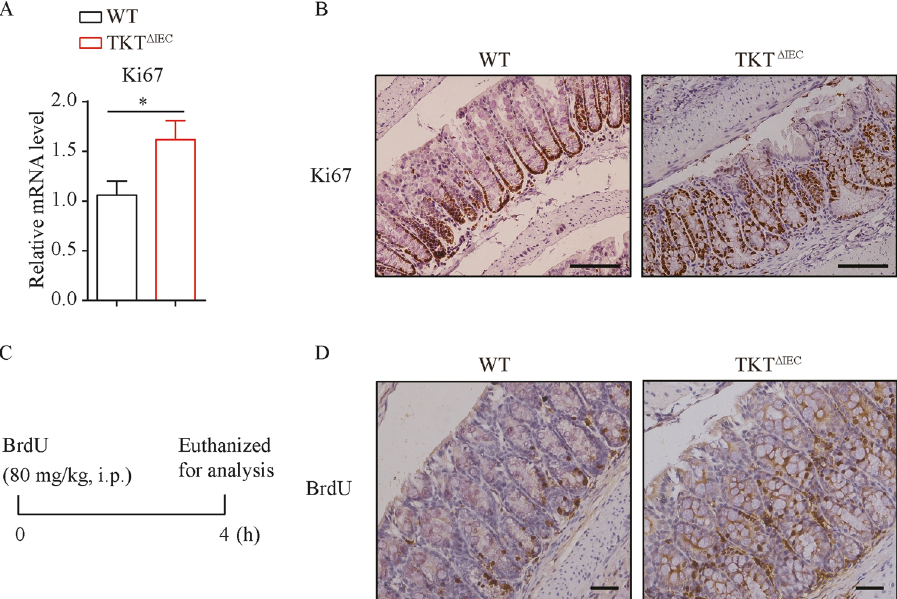
Fig. 6 TKT abrogation induces ectopic hyperproliferation in intestinal epithelium. A QPCR analysis of Ki67 expression in colons from 8-week-old WT and TKT Δ IEC mice ( n = 7 for WT mice, n = 9 for TKT Δ IEC mice). B Representative images of colon sections stained with the Ki67 antibody from 8-week-old WT and TKT Δ IEC mice. Scale bars, 100 μ m. C Schematic procedure of the BrdU pulse-chase experiment. D Representative images of colon sections stained with the BrdU antibody from 8-week-old WT and TKT Δ IEC mice i.p. injected with BrdU 4 h before euthanization. Scale bars, 50 μ m. Data are represented as mean ± SEM. Signi fi cance is determined by Student ’ s t test analysis, * P < 0.05, ** P < 0.01, *** P <